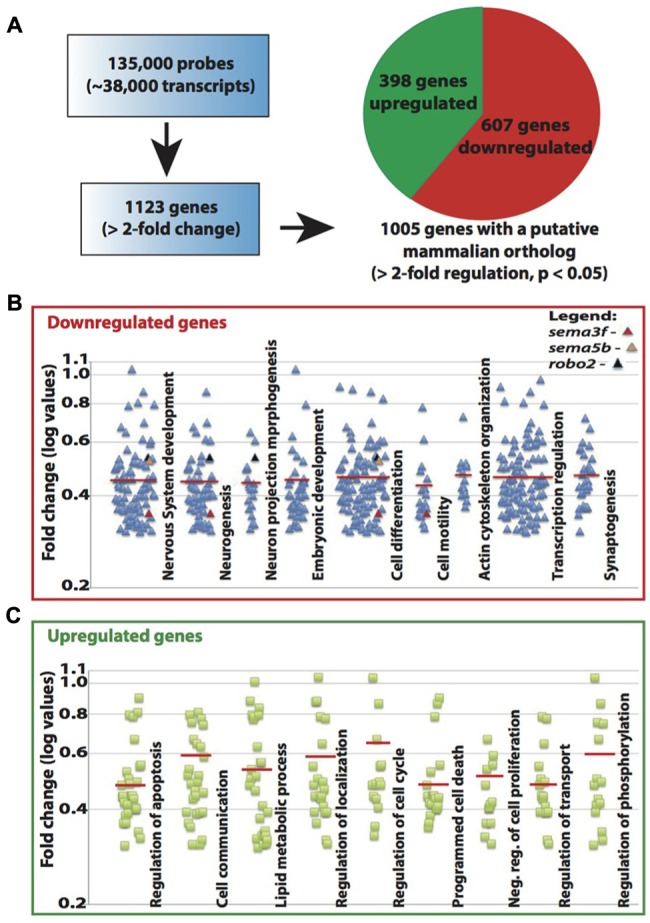
Mecp2 morphants showed decreased expression of axon guidance cues. Schematic diagram showing the number of genes that are upregulated or downregulated in Mecp2 deficient embryos (A). Out of the 1005 genes that were found to have putative mammalian orthologs, 607 were downregulated and 398 were upregulated (minimum twofold change; significance was established at p < 0.05) in Mecp2 morphants (A). Dot plots showing downregulated (B) and upregulated (C) genes. Each dot represent a single gene with at least twofold increased or decreased in expression presented as log values (base10) on y-axis. Relative fold change of downregulated genes, sema3f (0.352568), sema5b (0.523226) and robo2 (0.537693) were highlighted as colored dots (red, orange, and black respectively) in their respective functional groups.